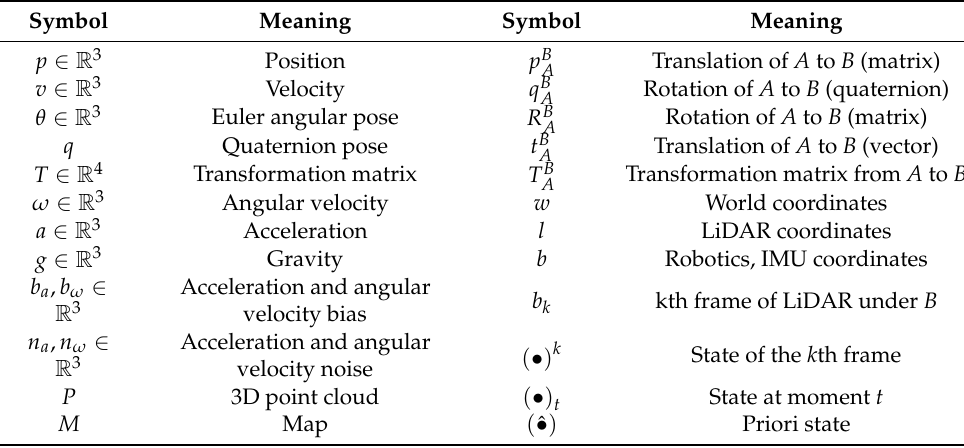
Table 1. Meaning of the variables involved in this paper.